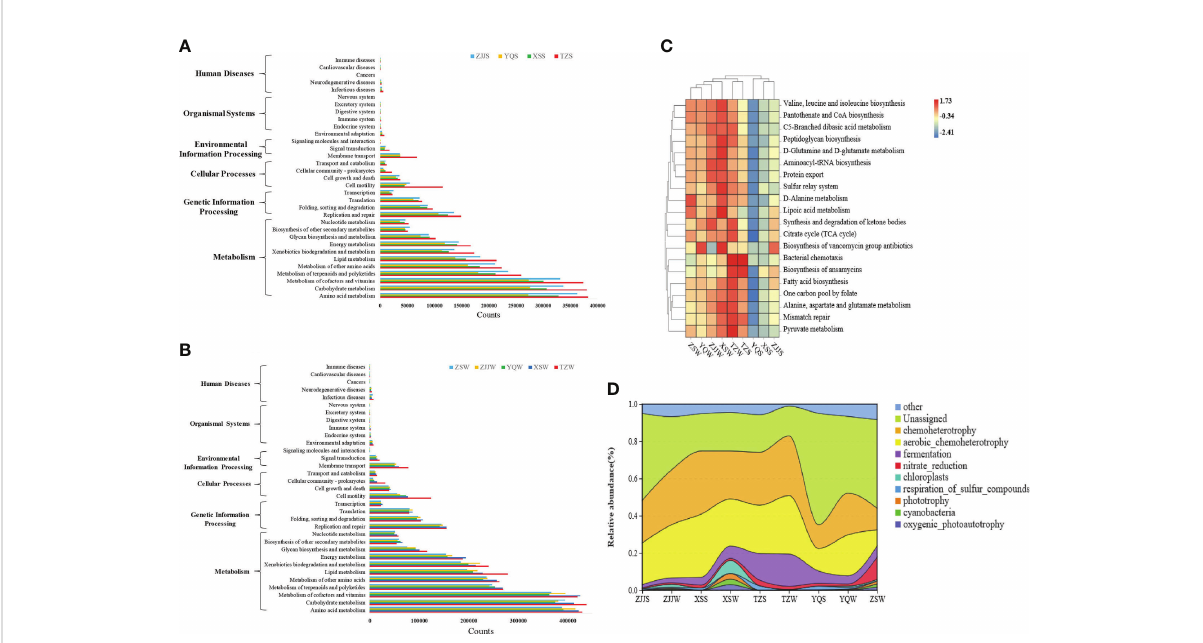
FIGURE 6 Predicted functional pro fi les for bacterial community by PICRUSt and FAPROTAX. (A, B) Histograms show the predicted functional categories (level 1) and subcategories (level 2) in the seawater and sediment groups. (C) Heatmap shows the top 20 abundant KEGG pathways (level 3) in all groups. (D) Rivermap shows the top 10 abundant ecological functional classes in all